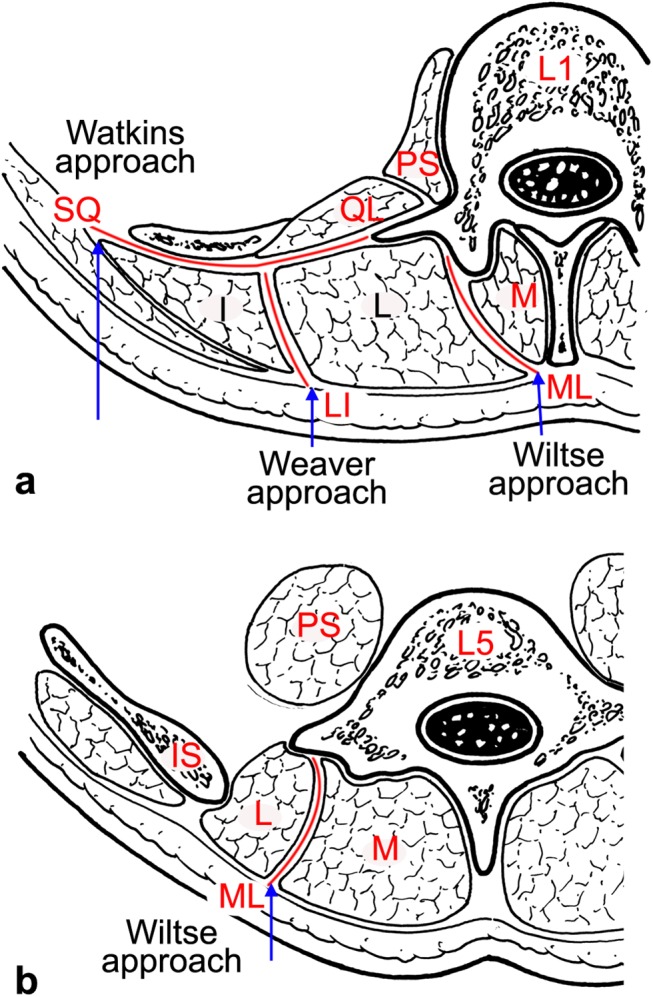
Illustration showing transverse sections at different levels of the lumbar region.(a) At the upper level of the lumbar spine, three cleavage planes within the paraspinal muscles were found: ML, SQ and LI, which are the entries used in the Wiltse, Watkins and Weaver approaches, respectively. (b) At the lower level of the lumbar spine, only ML was found, and its superficial location lied more laterally to the midline than the location at the upper level. The Wiltse approach through ML may be the best choice for protecting muscle integrity and its neurovascular supply. Arrow: incision site; M: multifidus; L: longissimus; I: iliocostalis; IS: iliac spine; QL: quadratus lumborum; PS: psoas major.